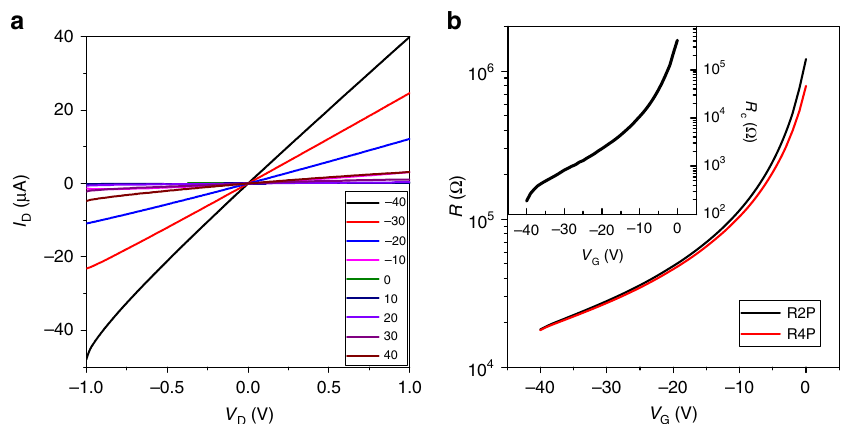
Fig. 2 Contact resistance at Cr-BP interface. a Output curves of the BP device with increasing V G values with a step of 10 V. b Two-probe and four-probe device resistance to extract the contact resistance, inset shows the obtained contact resistance